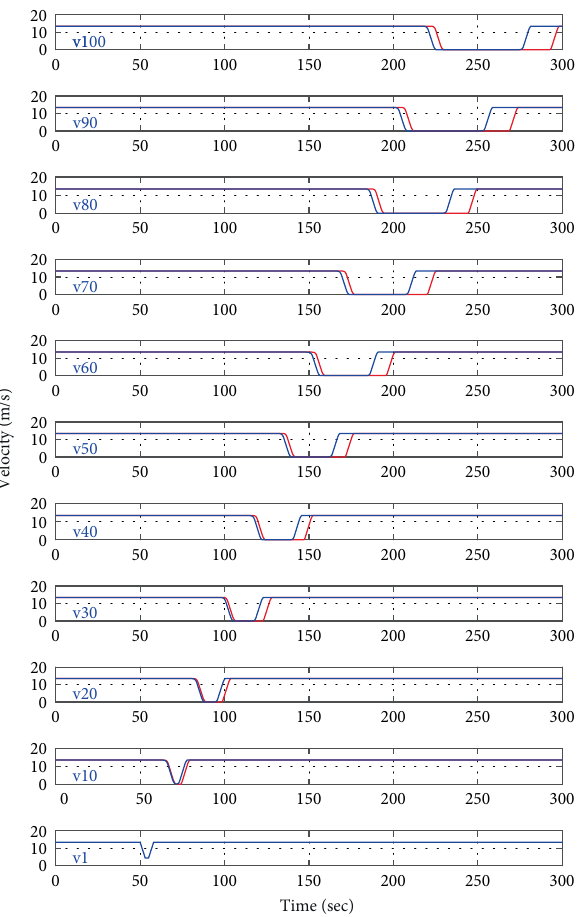
Figure 7: Velocity trajectories of 11 samples of vehicles in two simulations (blue lines and red lines represent simulation with only CAVs and simulation with only RVs,